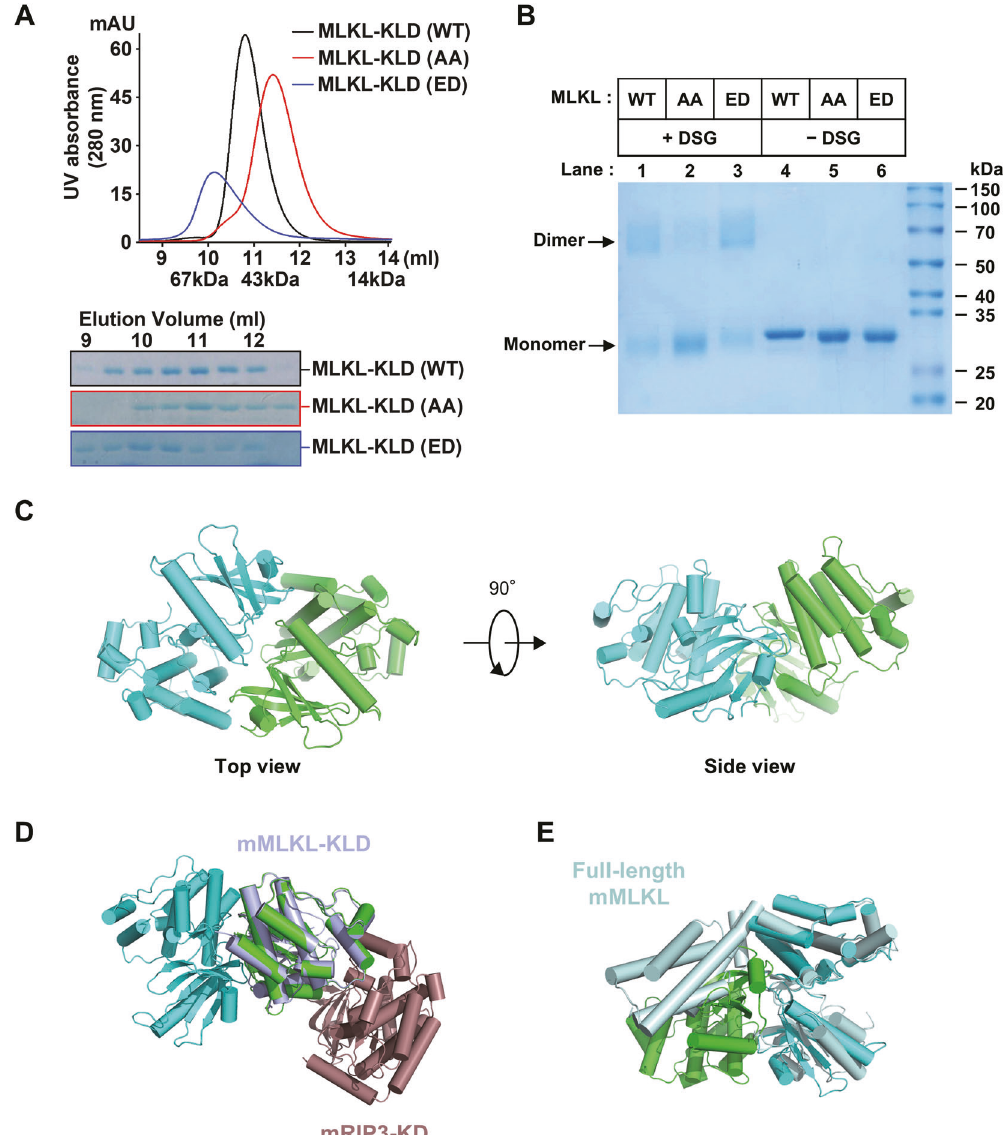
Fig. 1 The dimerization of MLKL kinase-like domain. A Gel fi ltration analysis of puri fi ed recombinant human MLKL kinase-like domain (KLD) proteins on Superdex 75. The elution fractions were applied to SDS-PAGE followed by Coomassie blue staining. The elution positions of size standards are indicated (BSA, 67 kDa; Ovalbumin, 44 kDa; ribonuclease A, 14 kDa). B Detection of self-assembly of recombinant human MLKL kinase-like domain proteins using chemical crosslinker. Aliquots of puri fi ed recombinant wild-type or mutant forms of MLKL KLD proteins were mixed with DMSO or crosslinker DSG as described in the MATERIALS AND METHODS, Samples were subjected to SDS-PAGE and stained by Coomassie blue. Abbreviations are as follows: DSG, disuccinimidyl glutarate; WT, wild-type; AA, phosphor-sites ’ mutant, T357A/S358A; ED, phosphomimic mutant, T357E/S358D. C Two perpendicular views of the overall structure of the phosphomimic mutant (T357E/S358D) of human MLKL kinase-like domain homodimer (green and cyan). All structural fi gures were prepared with PyMOL. D Structural comparison of the phosphomimic mutant (T357E/S358D) of human MLKL kinase-like domain homodimer (green and cyan) with the complex structure of mouse MLKL kinase-like domain (bluewhite) and mouse RIP3 kinase domain (brown) (PDB: 4M69). E Structural comparison of the phosphomimic mutant (T357E/S358D) of human MLKL kinase-like domain homodimer (green and cyan) with the full-length structure of mouse MLKL (palecyan, PDB: